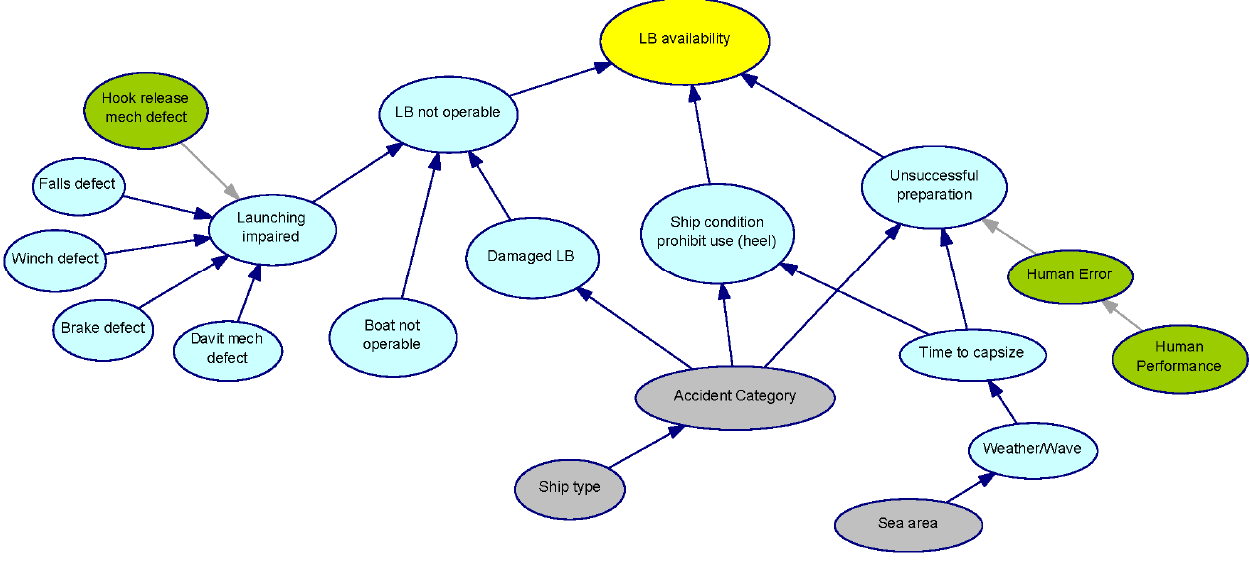
Figure A2. A Bayesian network for lifeboat availability in flooding accidents (03 FL ).